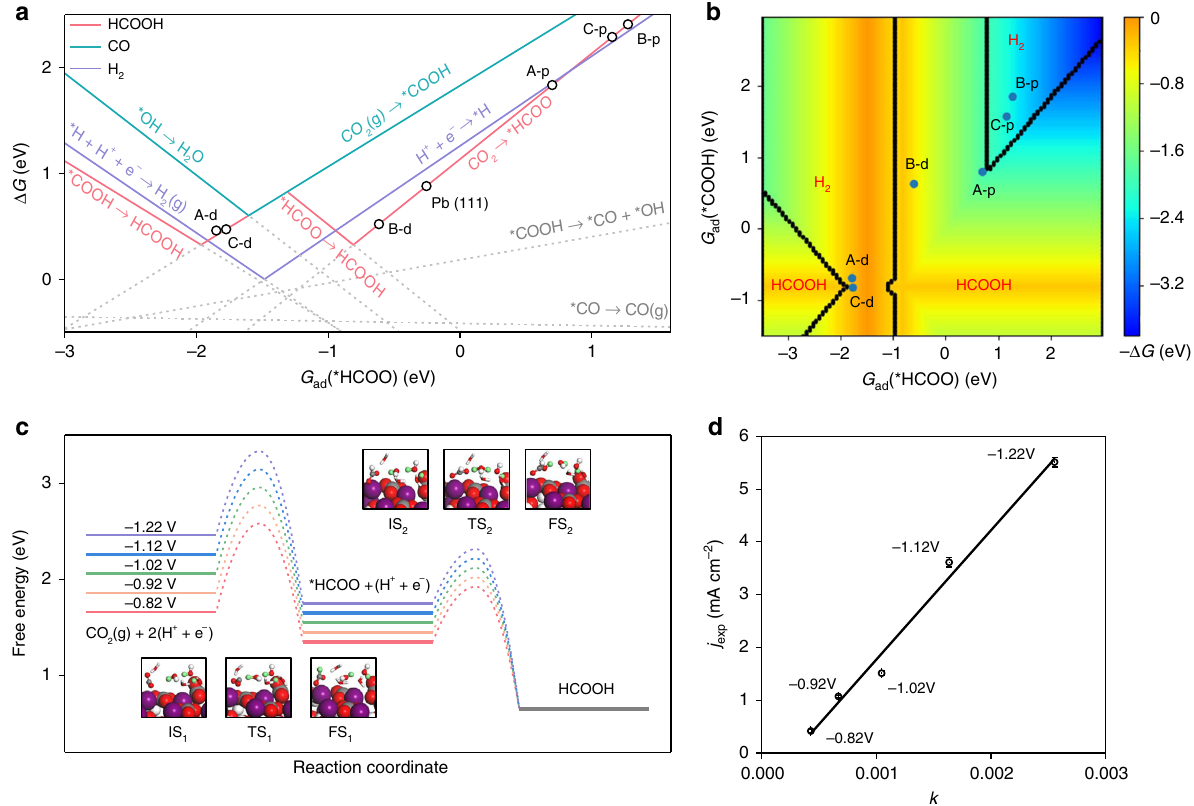
Fig. 4 Theoretically simulated the activity and selectivity of hydrocerussite. a Reaction free energies of involved elementary reactions plot versus G ad (*HCOO). b Two-dimensional map of activity and selectivity for CO 2 RR. Different regions represent different products, and colors represent the negative Δ G of GDS measured as the label on the right side. c Free energy diagrams of CO 2 RR into HCOOH under different experimental potentials; insets are structures of initial (IS), transition (TS) and fi nal (FS) state of CO 2 protonation (1) and HCOOH formation (2); purple, red, gray, and white atoms are Pb, O, C, and H, respectively; green atoms represent H that participate in the reaction. d Experimental partial current density of formate ( j exp )